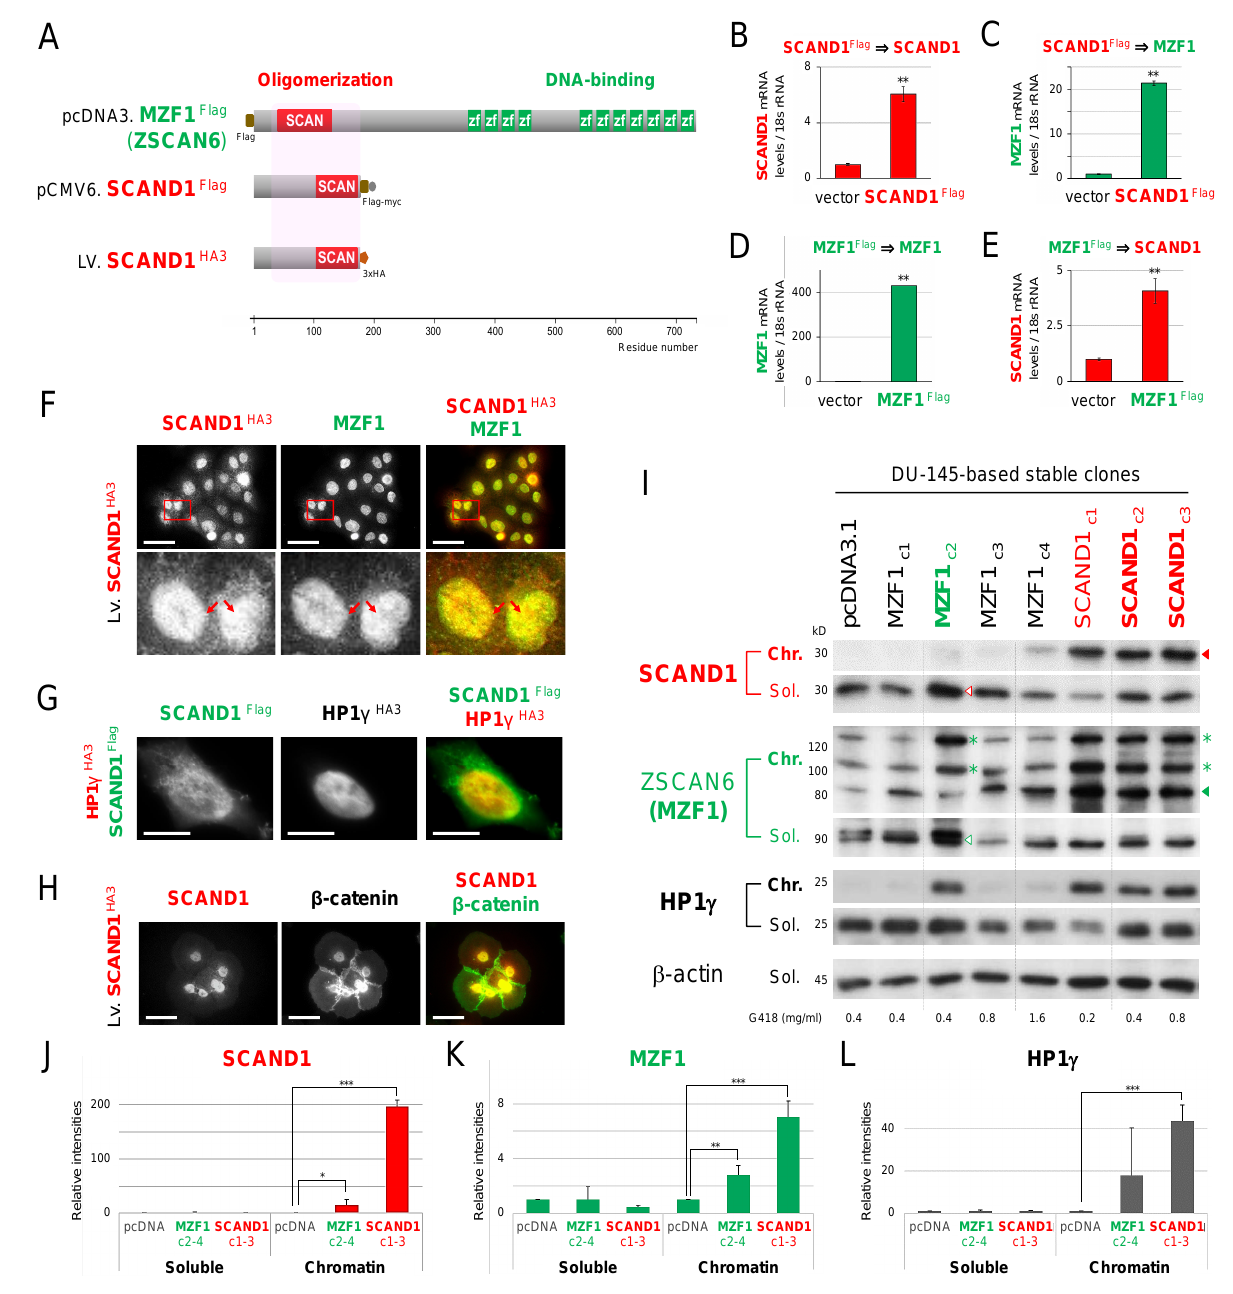
Figure 2. SCAND1 is mutually inducible with MZF1(ZSCAN6) and localized in hetero-chromatin. ( A ) Constructs for overexpressing MZF1 Flag , SCAND1 Flag , and SCAND1 HA3 . These were transfected into DU-145 cells, and stable clones were established. ( B – E ) qRT-PCR analysis of SCAND1 and MZF1 in the stable clones. ** p < 0.01, n = 3. ( F – H ) Confocal microscopy showing co-expression and co-localization between; ( F ) SCAND1 Flag vs. MZF1. Antibodies against HA-tag and MZF1 were used. Scale bars, 50 µ m. Arrows indicate speckles of SCAND1/MZF1. ( G ) SCAND1 Flag vs. HP1 γ HA3 . Overexpression plasmids were co-transfected into HeLa cells. Antibodies against Flag-tag and HA- tag were used. Scale bars, 10 µ m. ( H ) SCAND1 vs. β -catenin. Antibodies against SCAND1 and β -catenin were used. Scale bars, 50 µ m. ( I ) Western blotting showing SCAND1, MZF1(ZSCAN6),